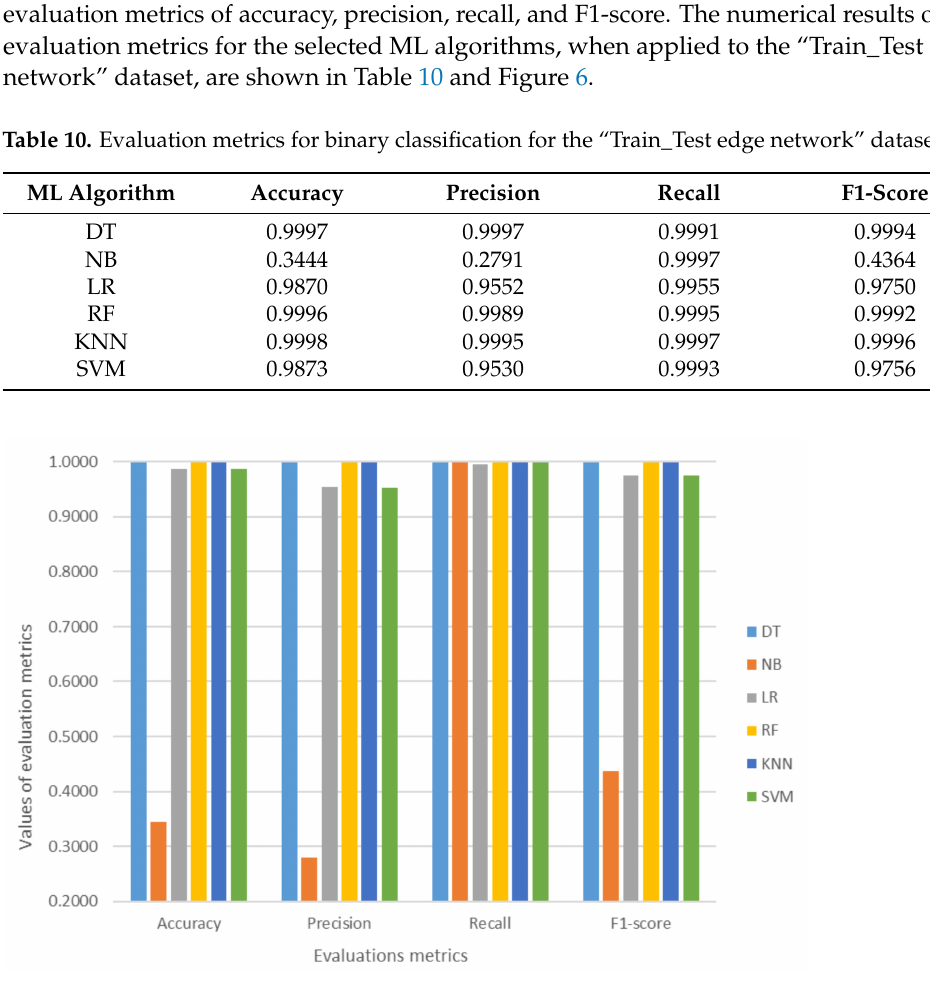
Figure 6. Evaluation metrics for binary classification for the “Train_Test edge network”